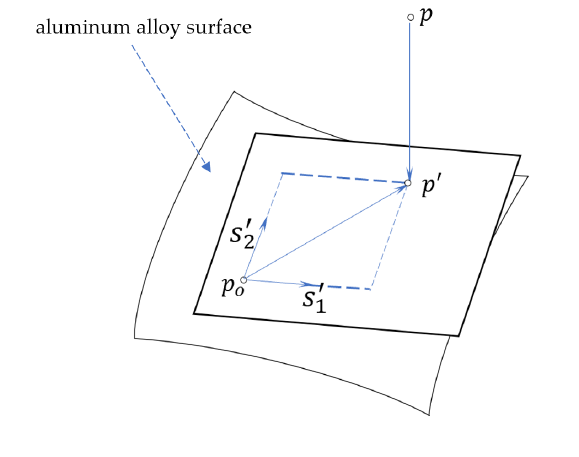
Figure 9. Schematic diagram of point projection on